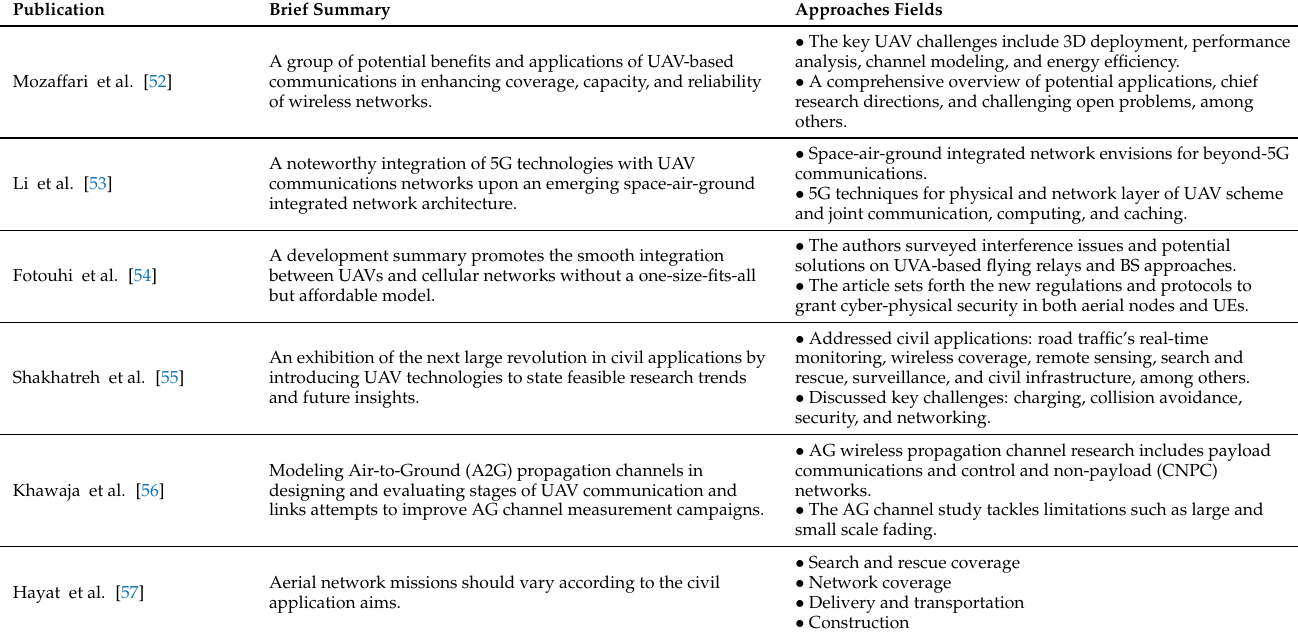
Table 3. Some surveys of UAV-based